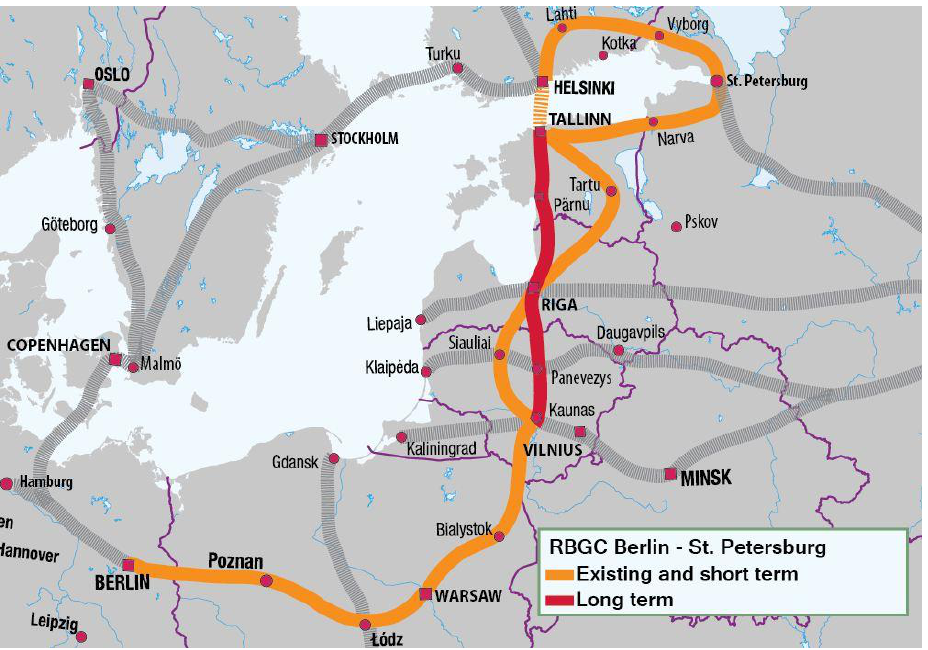
Figure 2 Rail Baltica Growth Corridor (RBGC), where existing and long- term planned one are marked with different